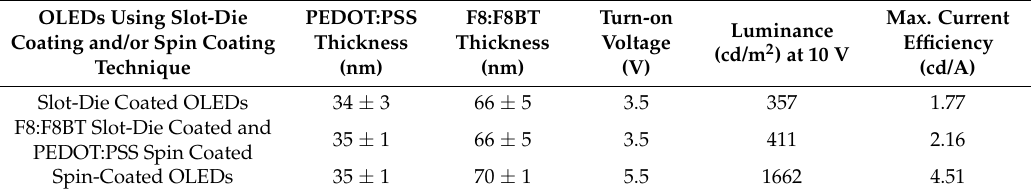
Table 2. Thickness of PEDOT:PSS and F8:F8BT layers formed using spin-coating and slot-die coating techniques, and the performances of the OLEDs fabricated using spin-coating and slot-die coating techniques.